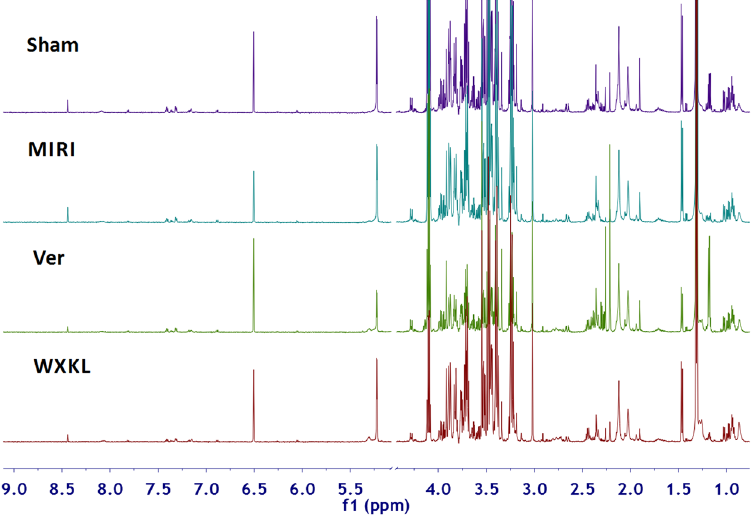
Figure 3. Typical standard 1 H-NMR spectra of plasma samples collected from sham, MIRI, Ver and WXKL rats. The keys for metabolites are given in Table 1.